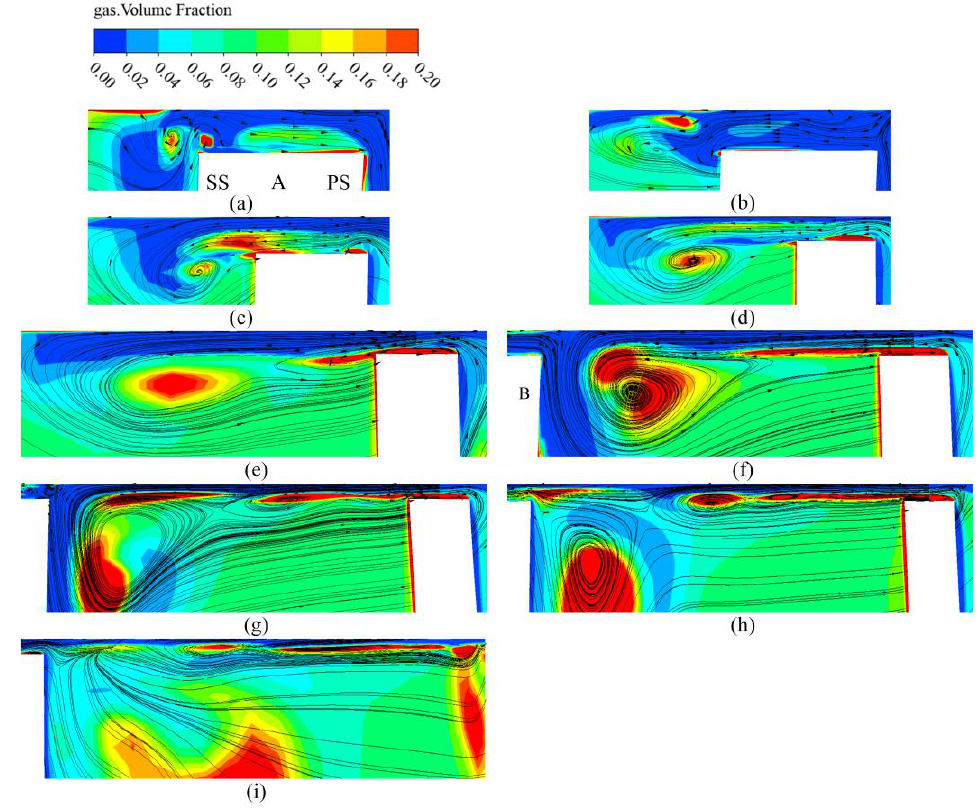
Figure 11. 2D evolution of the gas with the IGVF of 10%. ( a )T 0 ; ( b ) T 0 + 1/15T; ( c ) T 0 + 2/15T; ( d ) T 0 + 3/15T; ( e ) T 0 + 4/15T; ( f ) T 0 + 5/15T; ( g ) T 0 + 6/15T; ( h ) T 0 + 7/15T; and ( i ) T 0 + 8/15T.